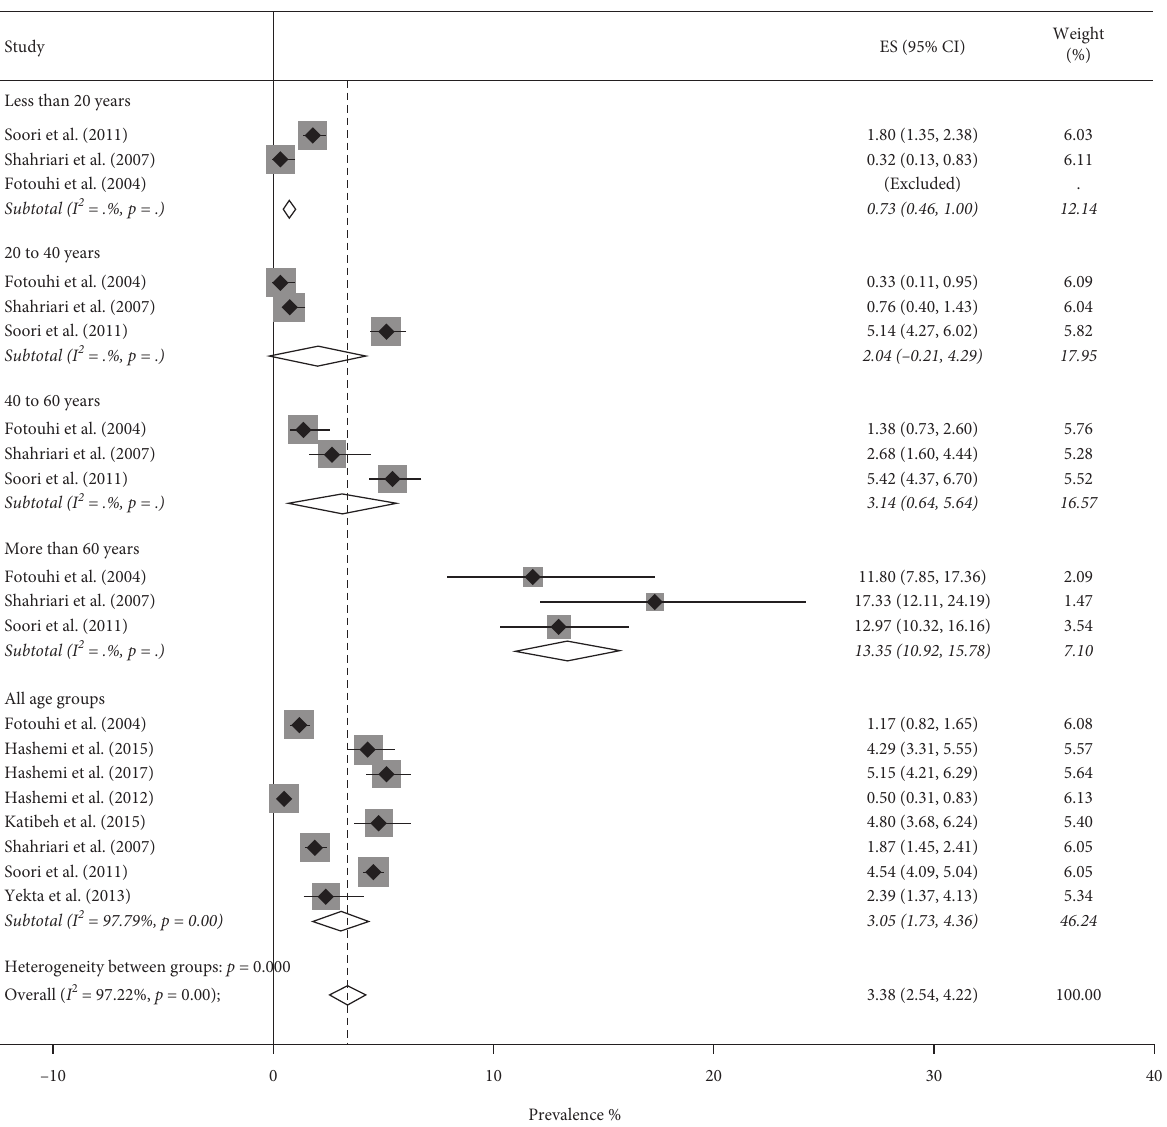
Figure 5: Forest plot of the prevalence of low vision among Iranian